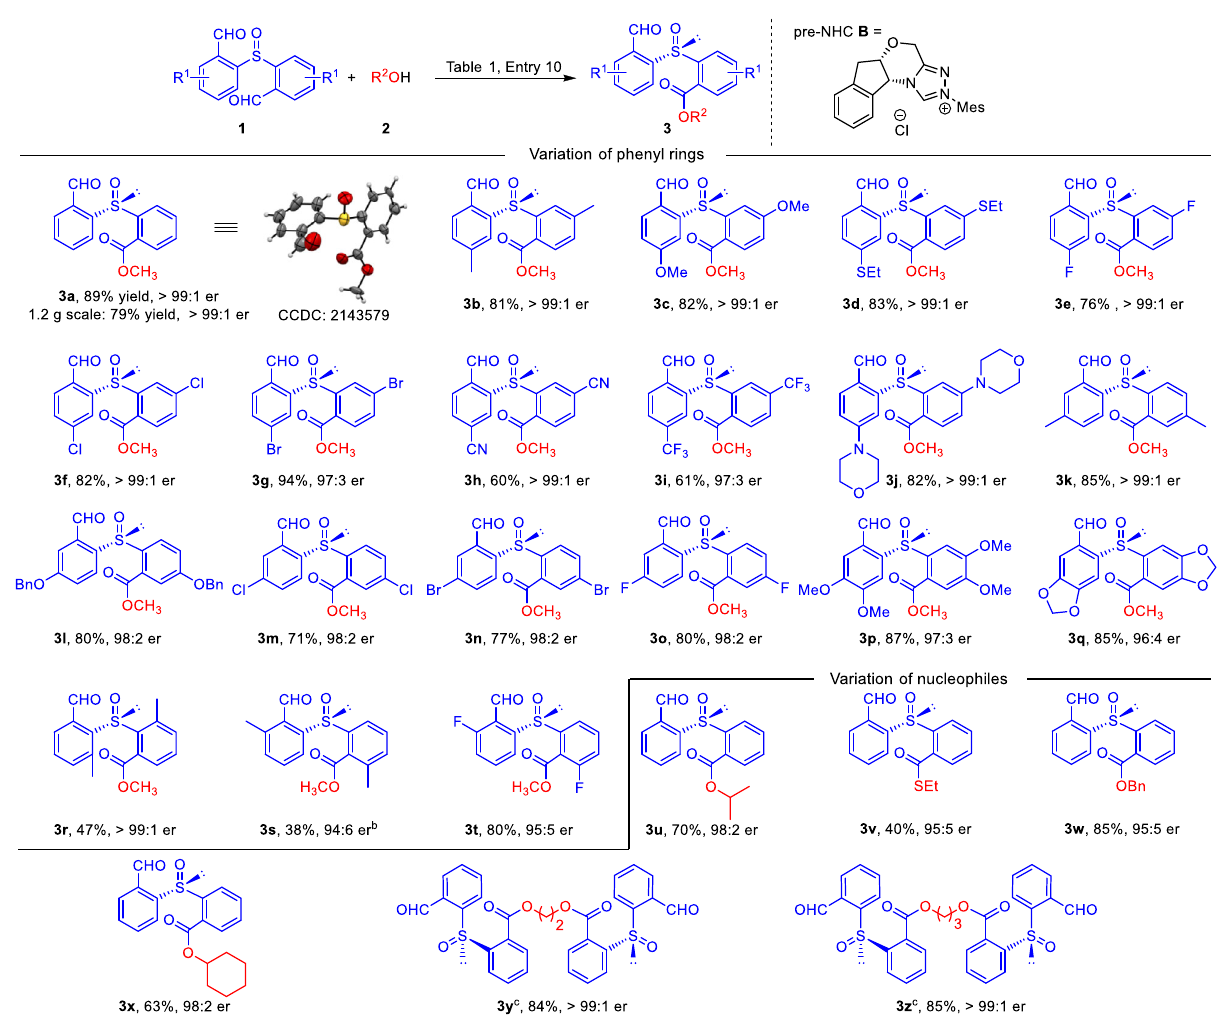
Fig. 2 | Substrates scope of the reaction a . a Reaction conditions as stated in Table 1, entry 10. Yields are isolated yields after puri fi cation by column chromatography. Er values were determined via HPLC on chiral stationary phase. b 50°C and THF as solvent. c 220 mol% 1a , DQ, K 3 PO 4 and 100mol% diol were